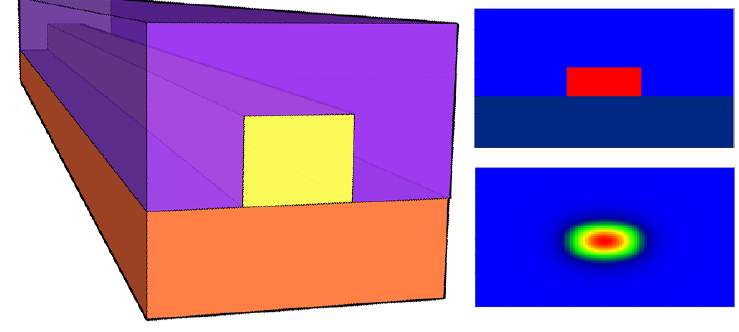
Figure 2. Three-layer polymer waveguide patterned with e-beam lithography, the side view and the guided